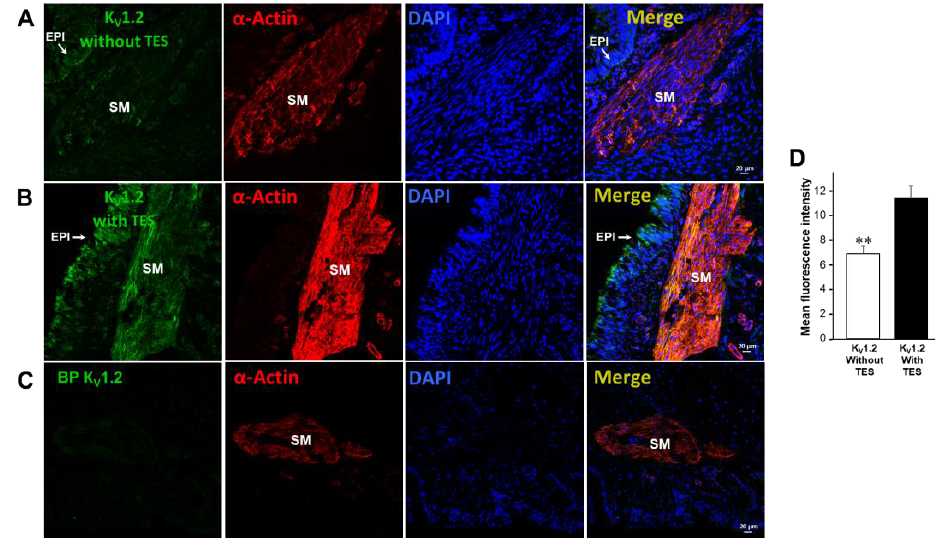
Figure 7. Upregulation of K V 1.2 in guinea pig airway smooth muscles induced by testosterone (TES) genomic effects is involved in theophylline-induced relaxation enhancement. In the first column, K V 1.2 immunofluorescence in guinea pig tracheal preparations without ( A ) and with ( B ) 48 h incubation with 40 nM TES is displayed in green on the airway smooth muscle. Note how the fluorescence increased as tissues were exposed to TES. Meanwhile, no fluorescence was observed when the blocking peptide (BP) was incubated together with anti-K V 1.2 ( C ). The second column shows α -smooth muscle actin (red), and the third column shows nuclei stained with DAPI (blue). The fourth column shows merged images of the first three panels. ( D ) Quantification of K V 1.2 levels expressed as mean fluorescence, n = 5. Error bars represent S.E.M. Significance was determined with an unpaired two-tailed t -test. ** p < 0.01. EPI = epithelium, SM = smooth muscle.